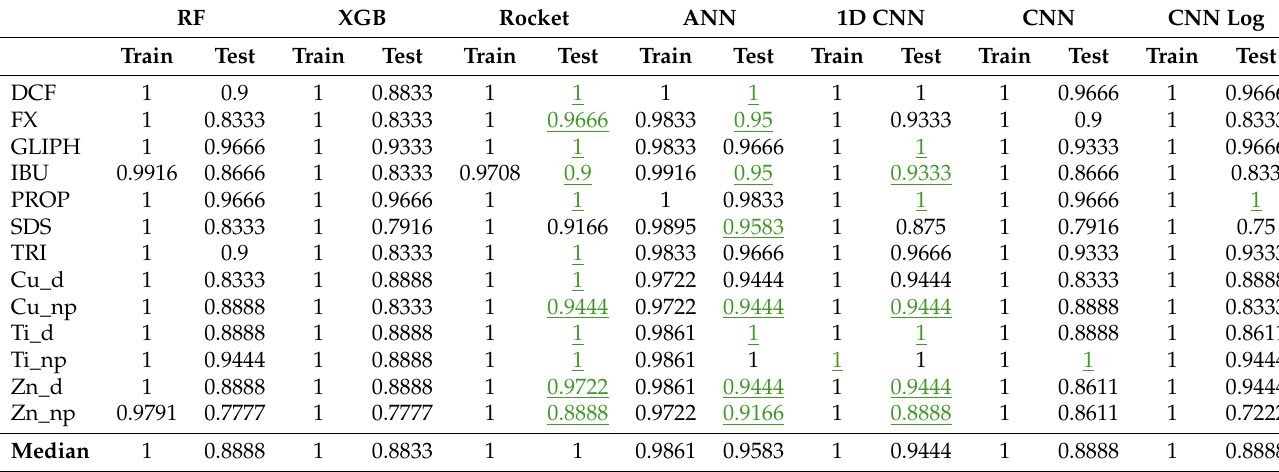
Figure 6. Heatmap depicting the accuracy per class of the models when predicting the different concentrations of the different ECs. This heatmap is a concatenation of 13 smaller ones. The x -axis lists all the ECs at different concentrations (see Table 1). Table 4. Median overall accuracy obtained by the different methods when predicting the different concentrations of the ECs on the training and test set. The best test results for each EC are represented in green. The last row reports the median results for all